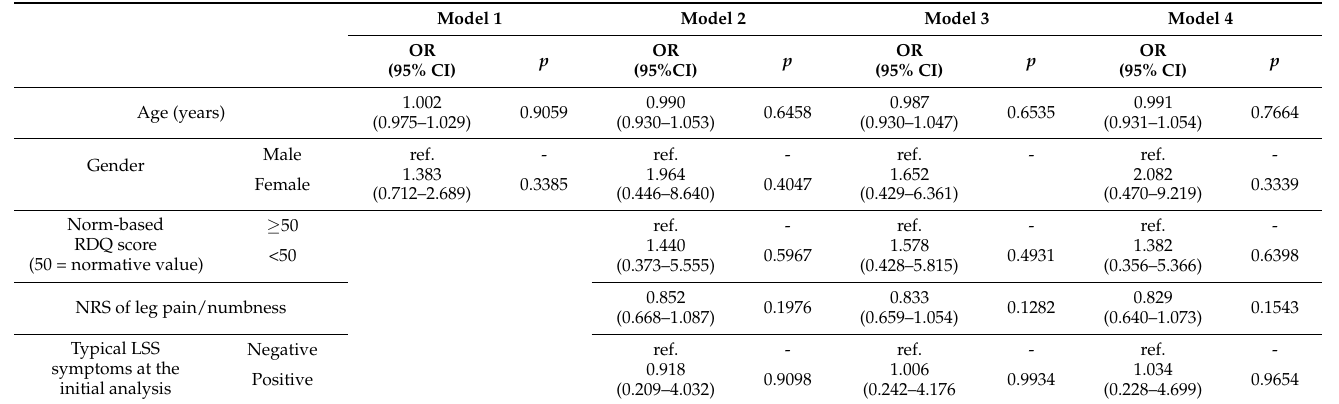
Table 5. A multivariate logistic regression analysis of predictive factors for the presence of LSS symptoms at the six-year